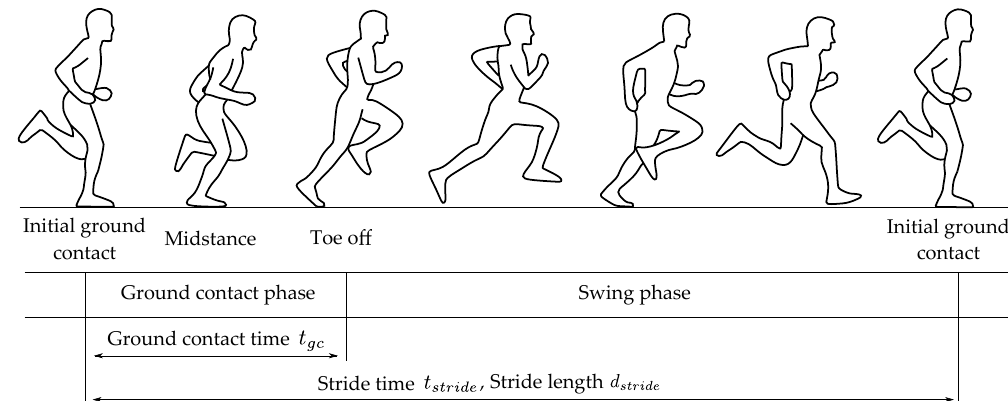
Figure 1. Visualization of the running gait cycle.